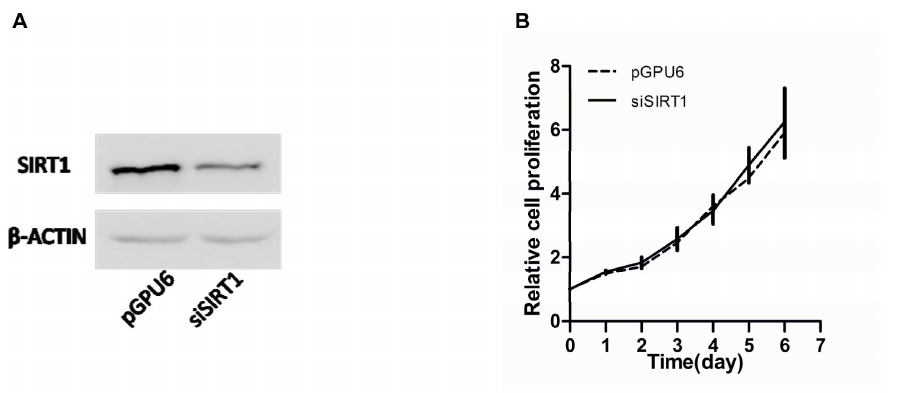
Figure 7. Effect of down-regulation of SIRT1 on PC-3 cell proliferation. ( A ) SIRT1 protein levels in PC-3 cells transfected with pGPU6 (empty vector plasmid) or siSIRT1 (pGPU6-si-SIRT1) by Western blot analysis. ( B ) Cell proliferation was quantitated using a CCK-8 assay. There were no significant differences between the two groups (P . 0.05). Data represent the mean value 6 SEM from three separate experiments.